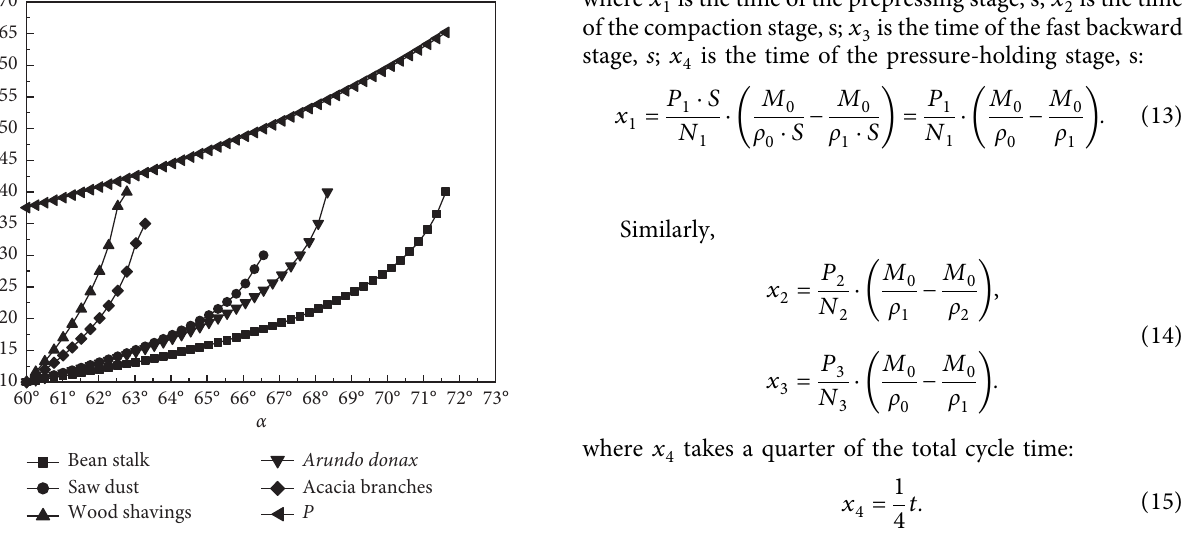
Figure 8: The relationship between material pressure and α